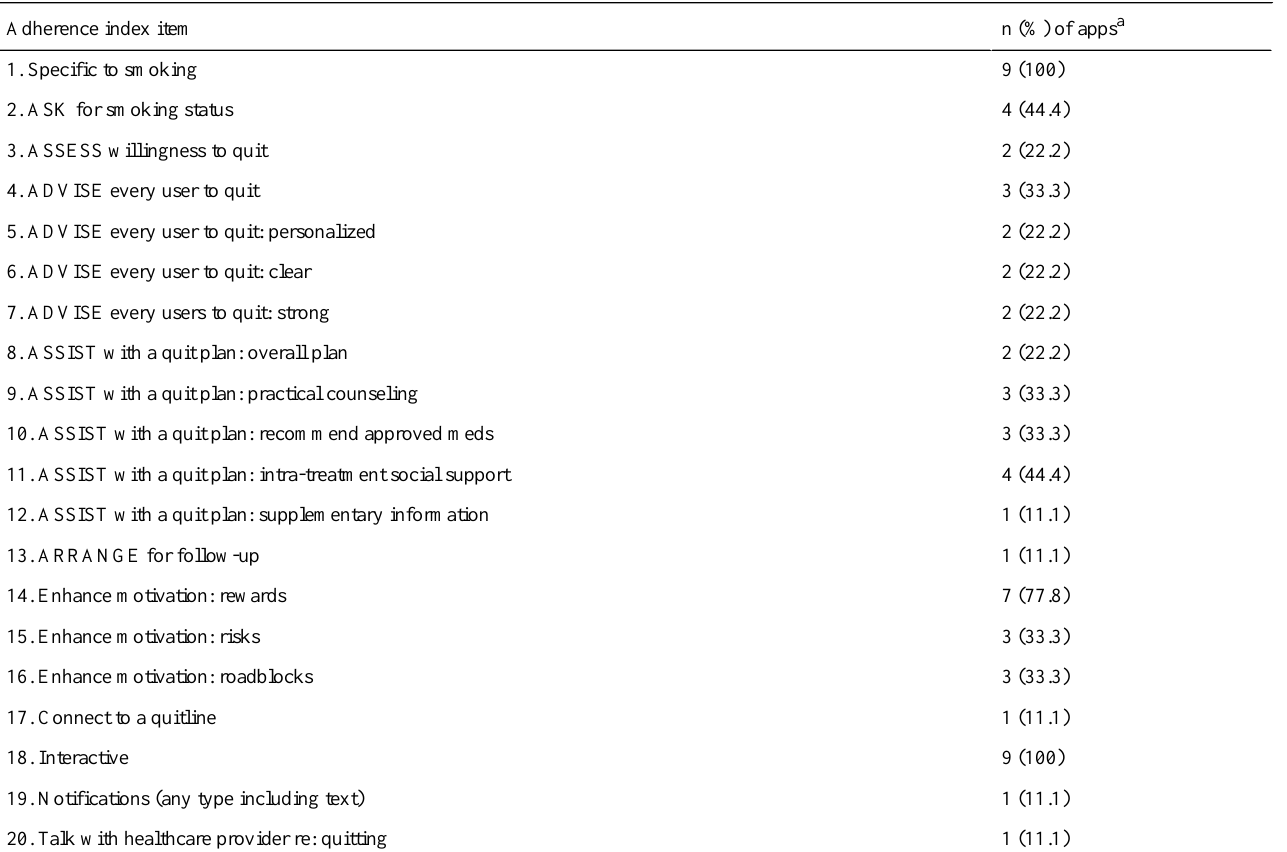
Table 1. Adherence index item endorsement across Facebook apps (N=9).